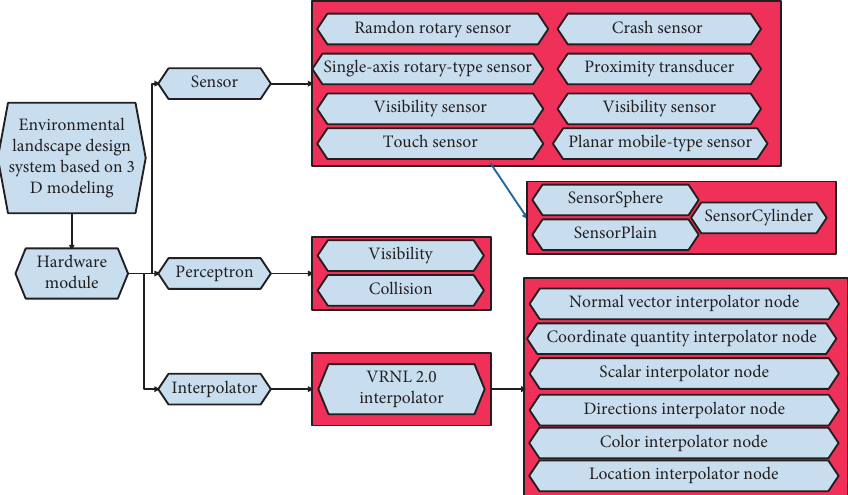
Figure 8: Environmental landscape design system based on artificial intelligence and digital space